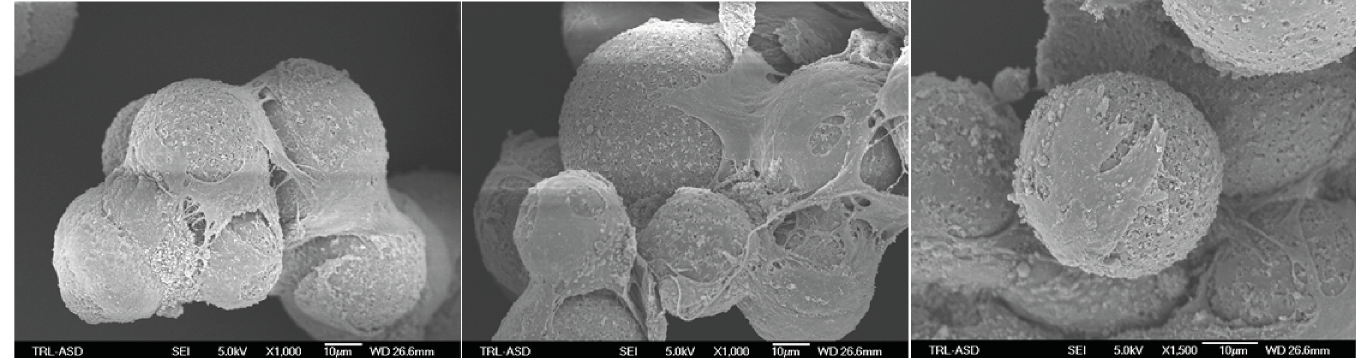
Fig 2. Scanning electron microscope micrographs of the recombinant human collagen-based microspheres loaded with porcine ASC. Original magnification is indicatedunderneaththe image. Abbreviation: ASC: adiposetissue-derived stromal cells.